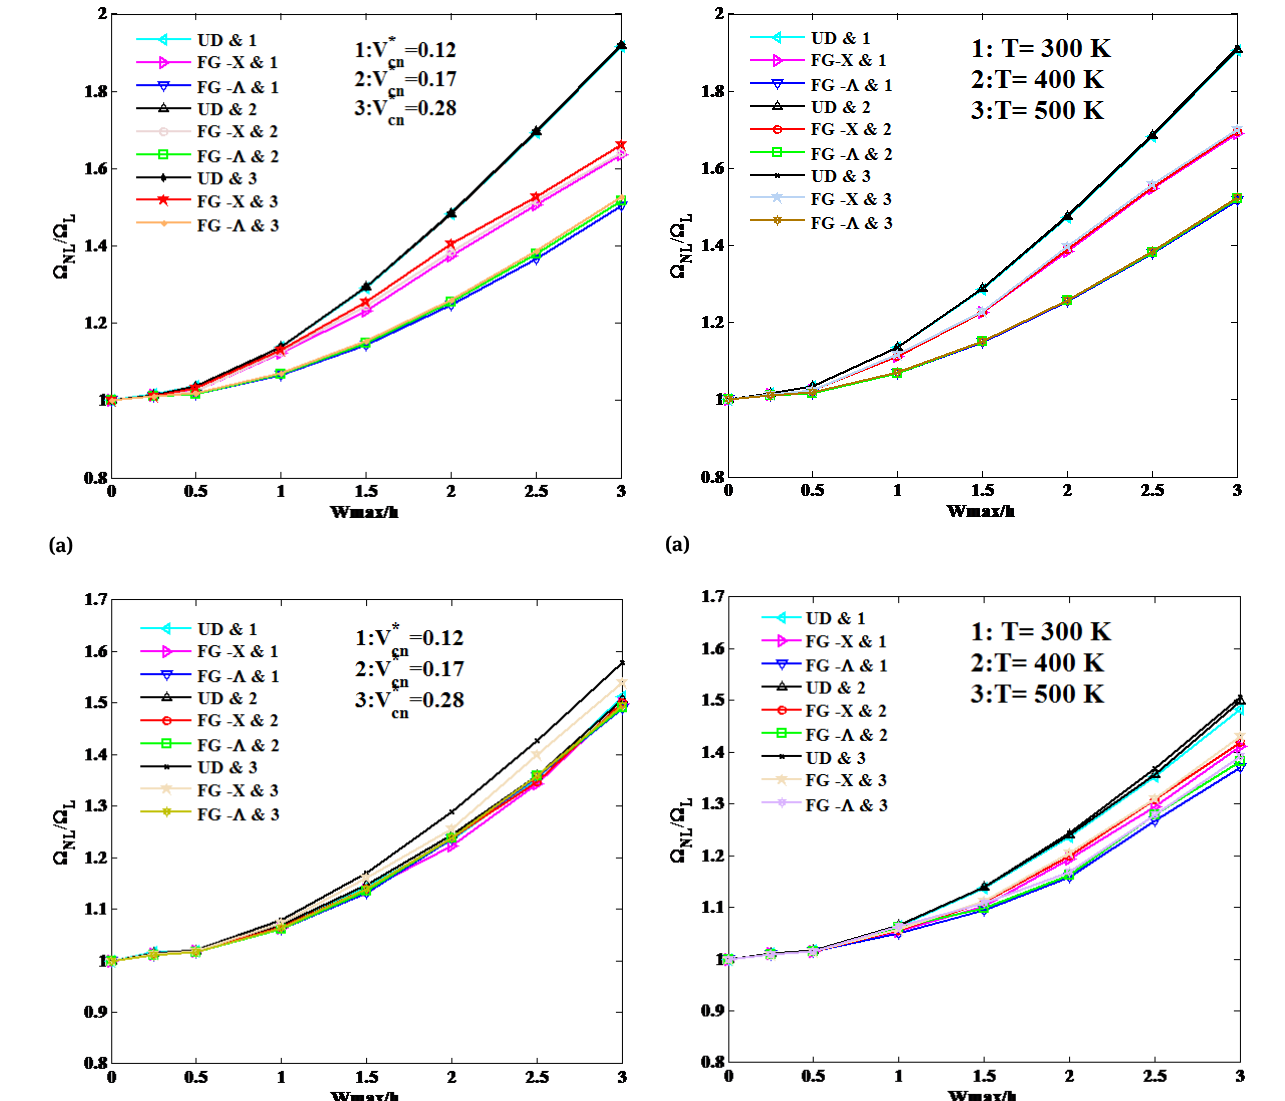
ported beam is highest while COV is highest for CS sup- ported beam. It is because of less number of edge con- strains present for CC supported beam. The dimensionless beam and COV of the fundamental frequency is lowered for elastically supported (WF) beam as compared to with- out supported (WOF) beam.